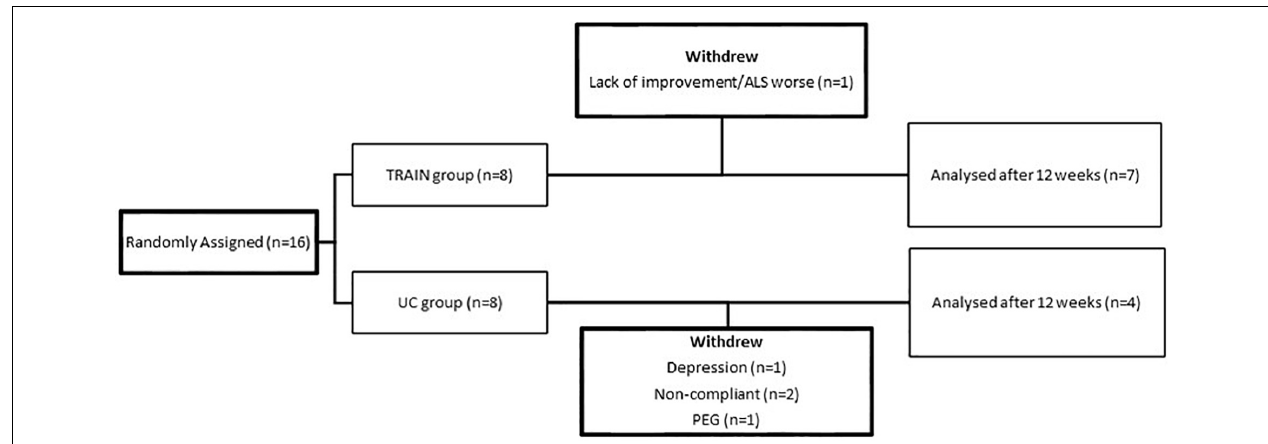
FIGURE 1 | Flow chart of participants from random assignment to interventions, withdrawals, and completion of the project.